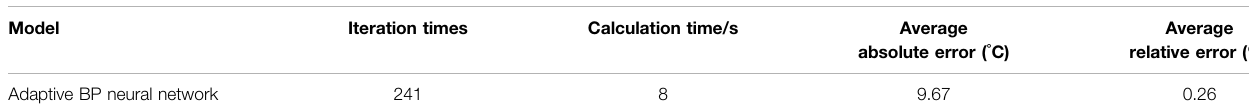
TABLE 2 | Comparison of calculation ef fi ciency.